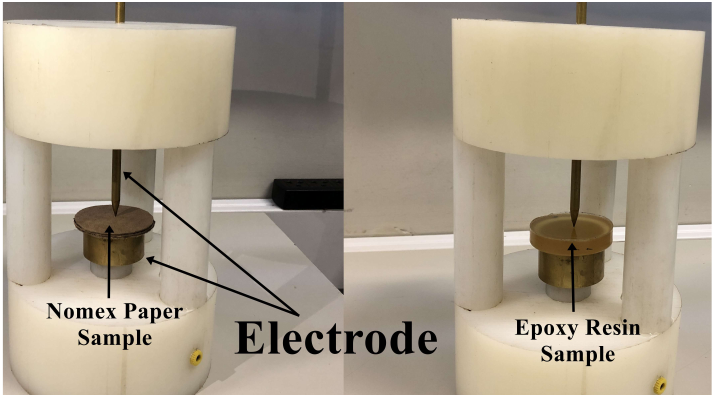
Figure 1. Electrode and material